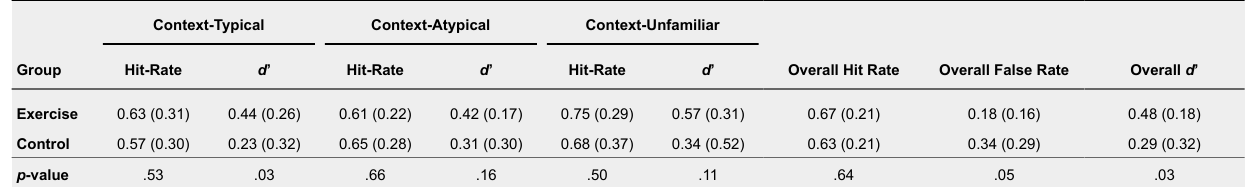
Mean (SD) Hit Rate, False rate, and Discrimination Index (d’) between the Exercise and Control